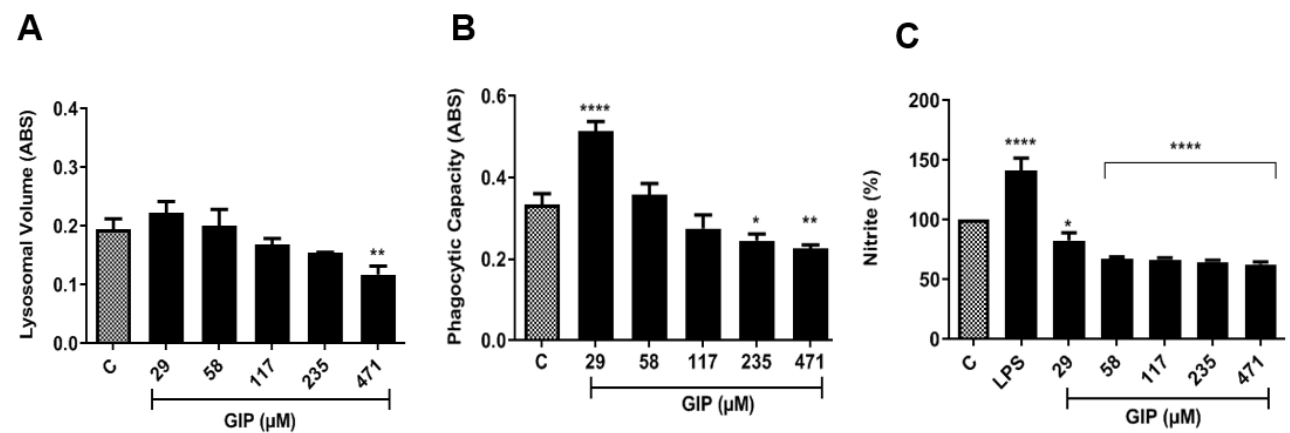
Figure 6. Influence of IPG on lysosomal volume, phagocytic capacity of murine macrophages and nitric oxide. ( A ) (Lysosomal volume); ( B ) (phagocytic capacity), and ( C ) (nitrite) represents the mean ± SEM of three experiments performed in triplicate, being * p < 0.05; ** p < 0.01; **** p < 0.0001. C — control, LPS — Escherichia coli lipopolysaccharide.